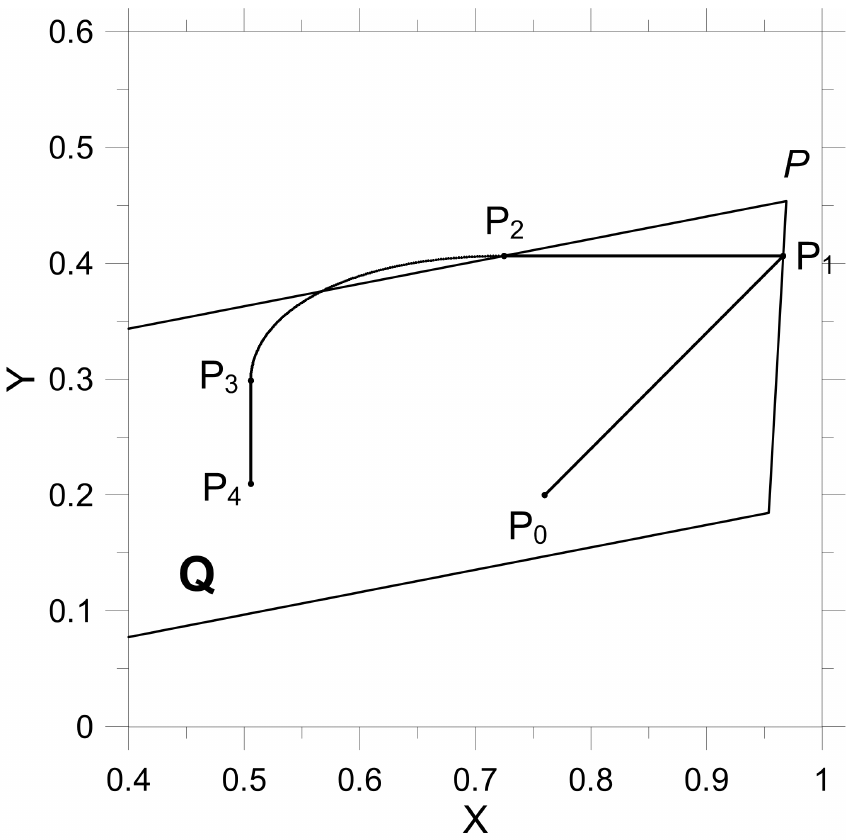
Figure 3. Orbit in the state space XY showing a 3-mode seismic event approximating the 2010 Maule earthquake, with the initial condition p = − 0.56. The event starts at point P 1 and terminates at point P 4